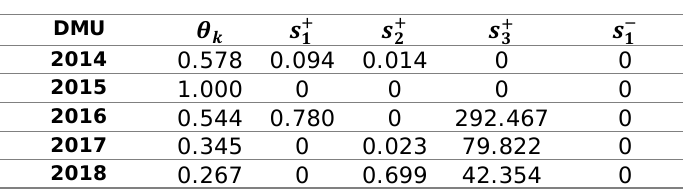
Table 3. Results of DEA